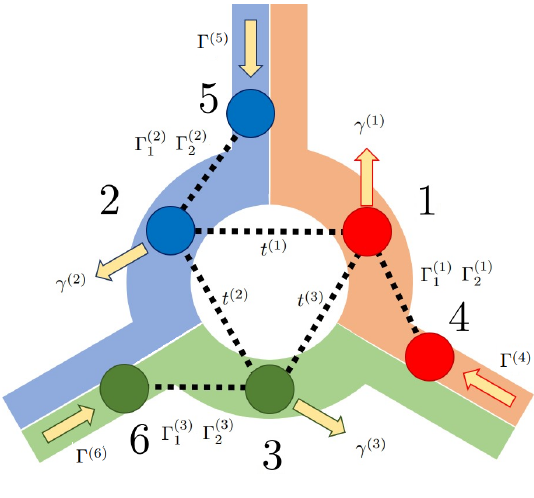
Figure 9: Sketch of the six-dot configuration for the open quantum crossroad. Com- pared to the minimal model in Fig. 1, we added three external sites. The baths that inject vehicles are now coupled to the external dots, with a flux proportional to Γ ( (cid:96) ) , (cid:96) = 4,5,6, while the outgoing baths are coupled to the internal sites, with a flux pro- portional to γ ( (cid:96) ) , (cid:96) = 1,2,3. The decision about the exit is made before entering